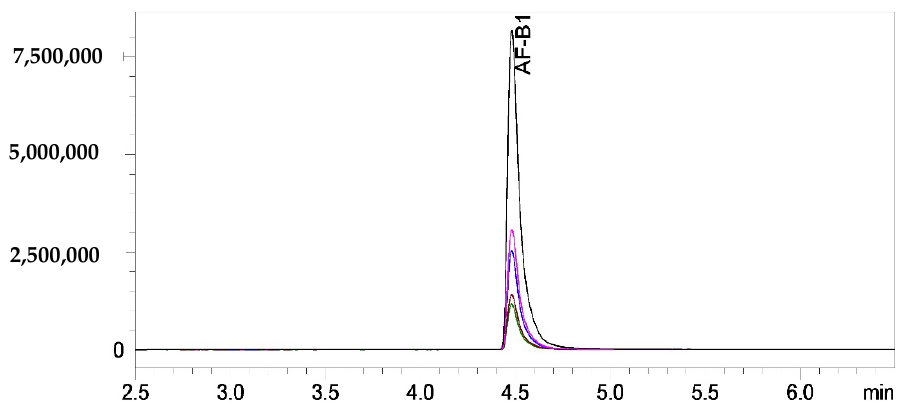
Figure A1. A representative Multiple Reaction Monitoring (MRM) chromatogram of AF-B1 was identified by a Shimadzu UHPLC-MS/MS.